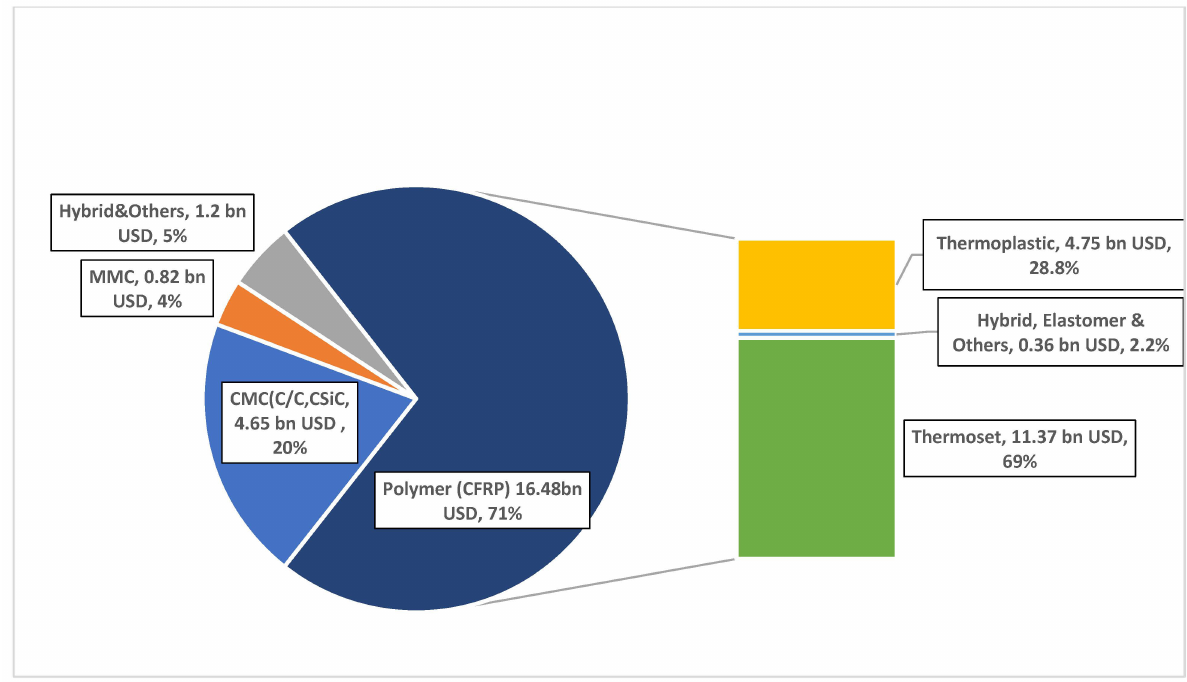
Figure 2. Key: MMC = metal matrix composites; CMC = ceramic matrix composites; CFRP = carbon fiber-reinforced polymer. Carbon composite’s market share segmented by matrix material (repro- duced from